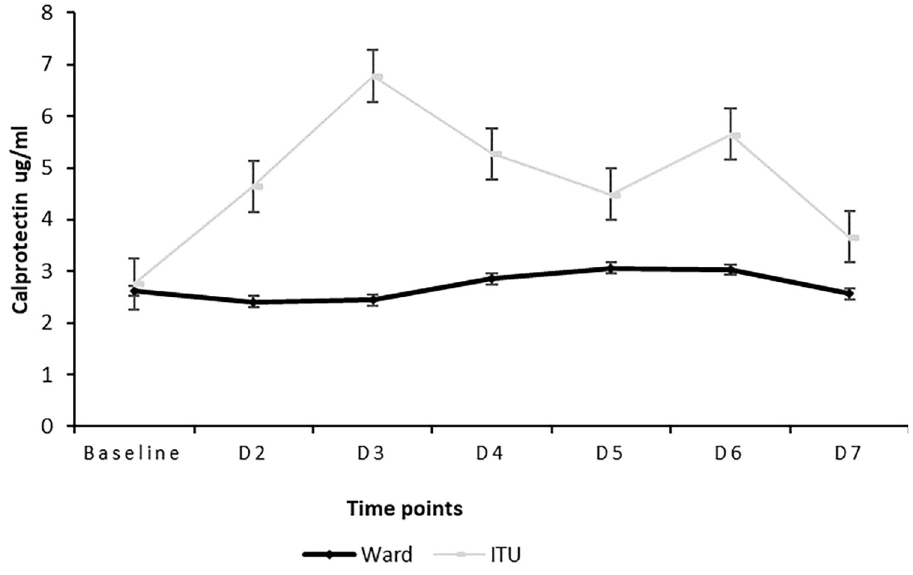
Fig 1. Calprotectin trend between ITU patients and those on the ward for admission through to week 2. Normal range for calprotectin is < 1.99 μ g/ml.